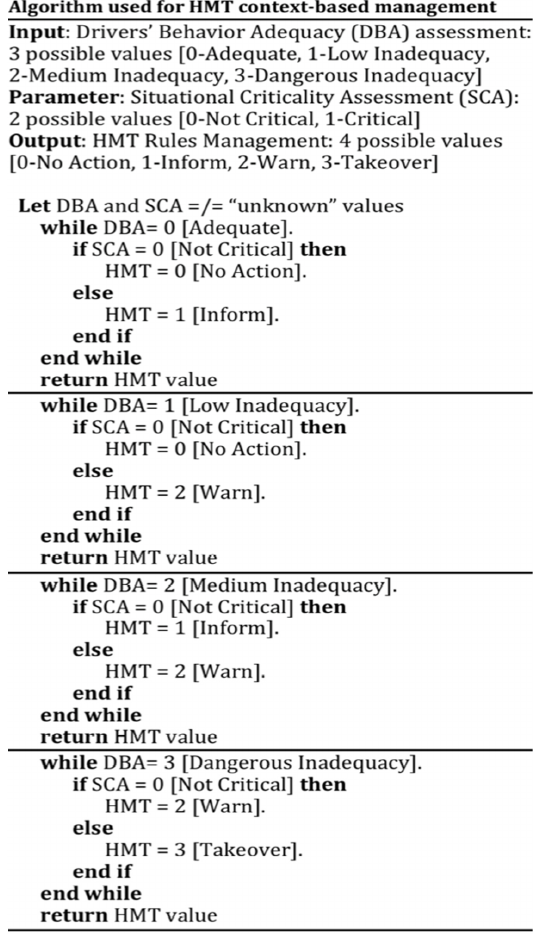
Figure 7. Human centered artificial intelligence (HCAI) algorithm supporting the HMT con- text-based manager.